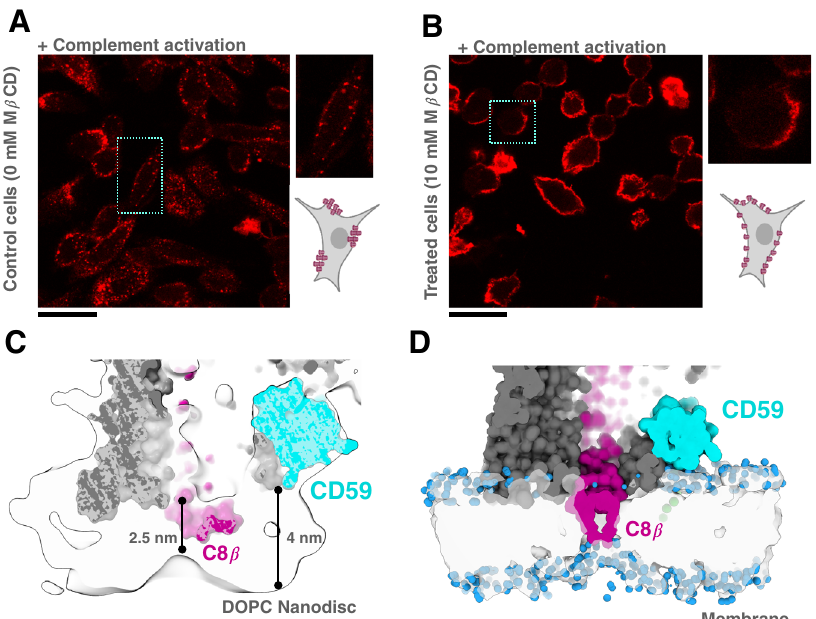
Fig. 5 | In fl uence of the membrane environment on MAC assembly and inhi- bition. A , B Cholesterol depletion assays. A representative image (out of 10 ran- domly selected locations) for each condition is shown. Scale bars, 50 μ m. A Complement was activated on CHO cells with a polyclonal anti-CHO IgG anti- body. Cells were incubated with C9-depleted human serum supplemented with a chemically labeled fl uorescent C9 (C9-Alexa fl uor 568) capable of forming MAC. B CHOcellstreatedwithM β CDtodepletecholesterol.Complementactivationand C9 detection is as described in ( A ). Insets show a zoomed in view of single cell.